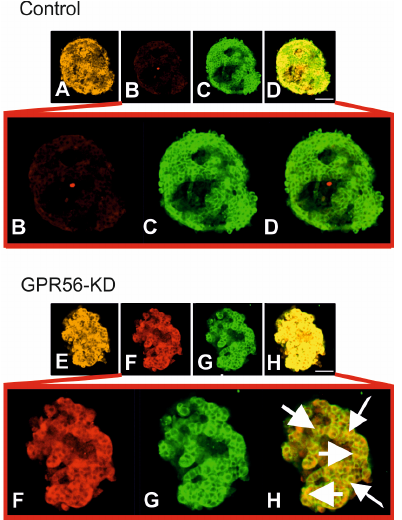
Figure 3. A representative confocal microscopy image of mouse islets double immune-labelled for insulin (beige) ( A , E ) and mitochondrial VDAC1 (red) ( B , F ), SNAP-25 (green) ( C , G ) and merged ( D , H ) in scramble control and Gpr56-KD mouse islets. Co-localization of VDAC1 and the membrane marker SNAP-25 is seen as orange-yellowish fluorescence in insulin-subtracted images. Bar indicates 20 µ m. Increased magnifications of the same image ( B – D ) and ( F – H ) are also